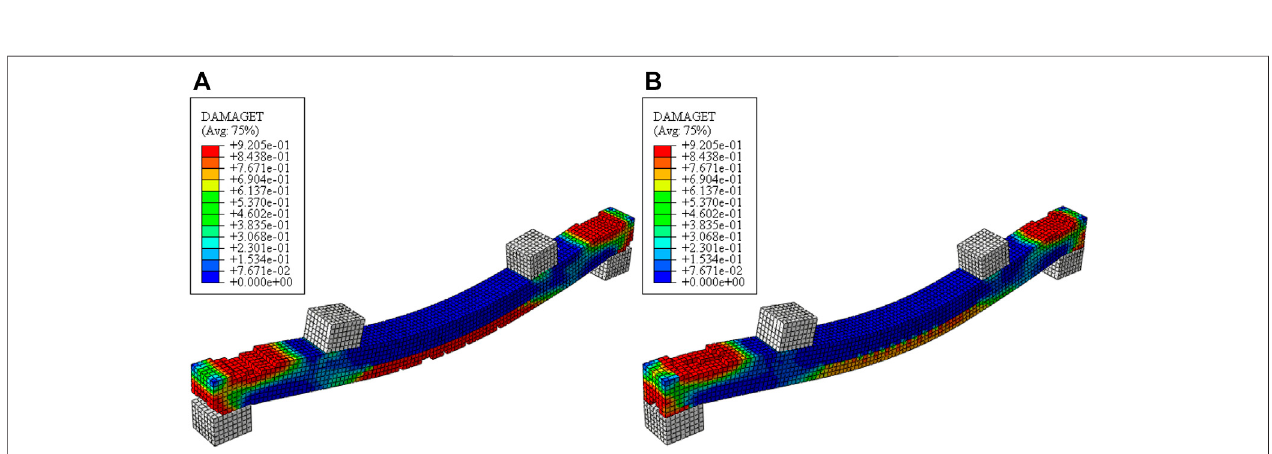
FIGURE14| Breakageofvarioustypesofconcretecolumnsunderequivalentultimateloadinfeature-1zone: (A) CFRP-wrappedconcretereinforcedcolumns; (B) CFRP reinforced concrete columns; (C) ordinary reinforced concrete columns.